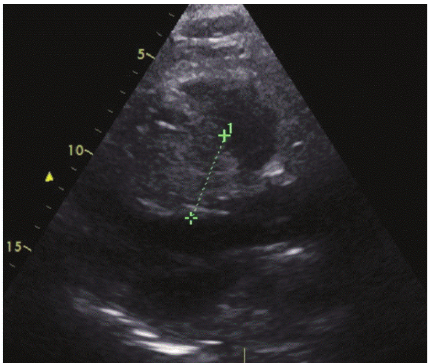
Figure 4: Echocardiogram shows a huge swelling of the intraven- tricular septal wall with compression of the right